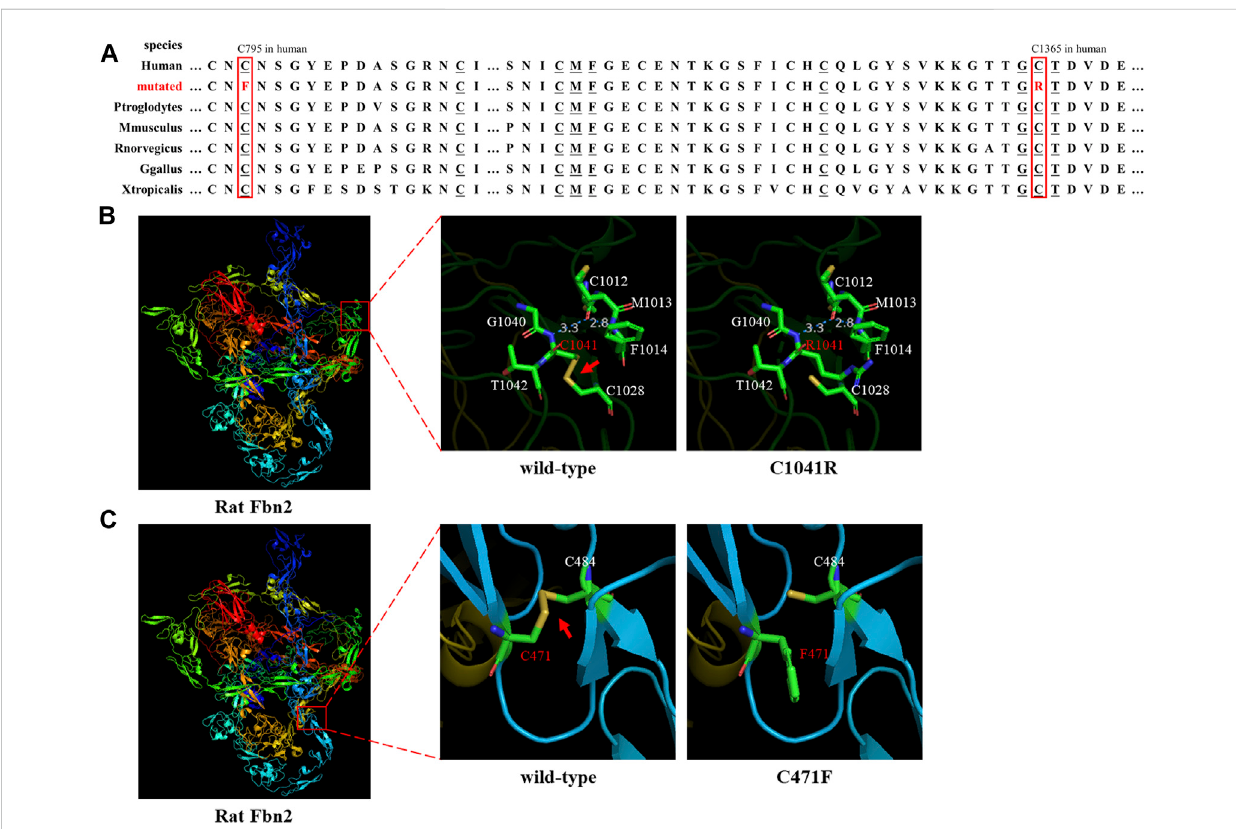
FIGURE 2 Species conservation analysis and protein modeling. (A) Species conservation analysis of the mutant amino acid sites of FBN2. The red box representsthemutantaminoacidsiteinvariousspecies.UnderlinedaminoacidscorrespondtothoselabeledinFigures2B,Cthatarehighlyevolutionarily conserved. (B,C) Three-dimensional model of rat FBN2 with wild type or p.C1041R/p.C471 variant. The red arrow points to the disul fi de